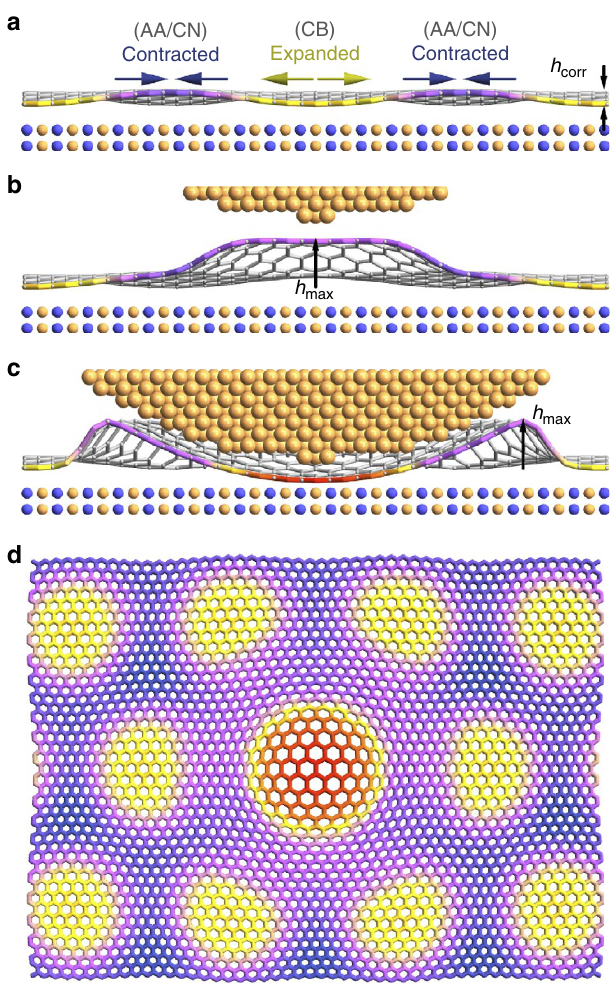
Figure 1 | Schematic of graphene on hBN and the influence of an STM tip. ( a ) Schematic of an aligned graphene on hBN heterostructure. Due to the spatially modulated vdW adhesion potential, the graphene lattice periodically expands and contracts in-plane. An out-of-plane corrugation profile also develops, both matching the moire´. ( b ) In the presence of an STM tip, a vdW adhesion between the tip and graphene lifts the graphene off the surface of the hBN, modifying the strain field. ( c ) For an STM tip very close to the surface, the graphene is pushed closer to the hBN, enhancing the difference in the adhesion potential for different stacking configurations. The graphene lattice then expands to match the slightly longer lattice constant of the hBN. ( d ) Top view of ( c ), where the STM tip sits in the centre of a moire´ period (that is, over a CB stacking configuration). The graphene lattice expands locally (red) to match the hBN lattice. Both the lattice constant and the spatial deformation have been scaled up for better